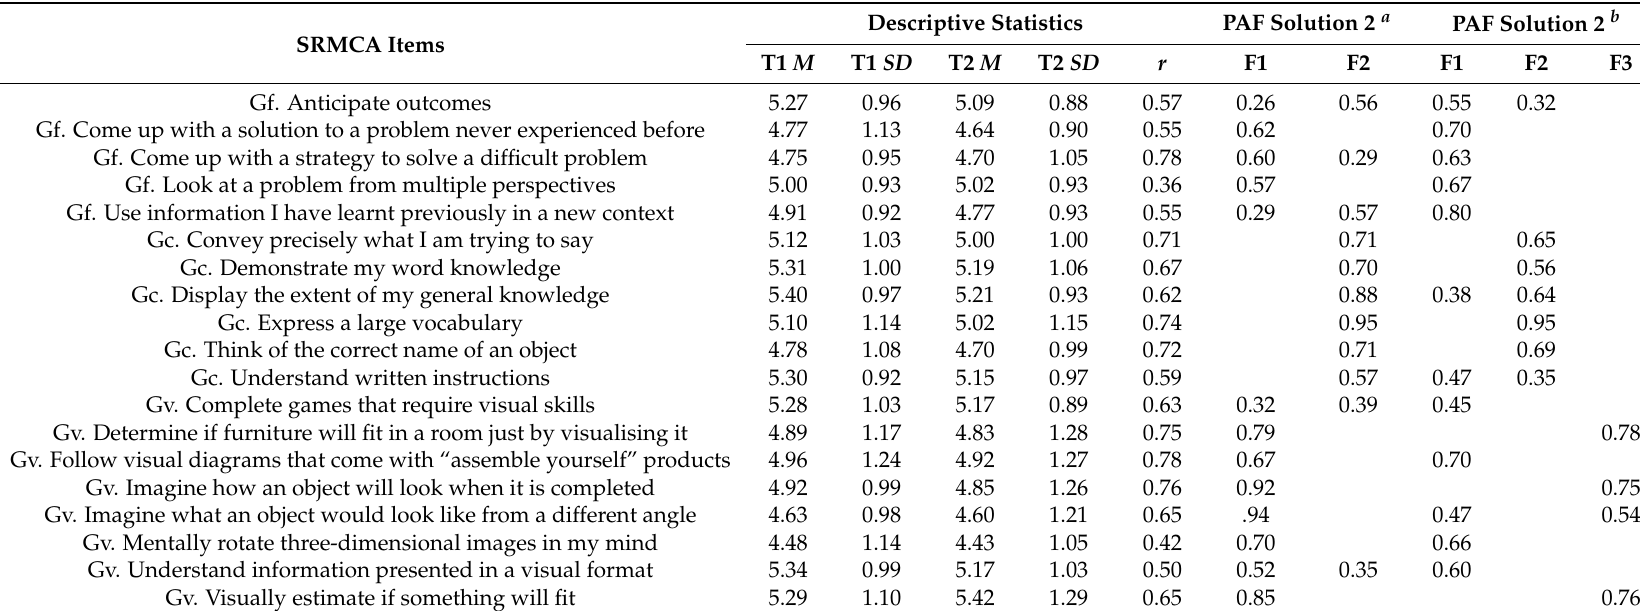
Table 2. Descriptive statistics for SRMCA items and item loadings resulting from Principal Axis